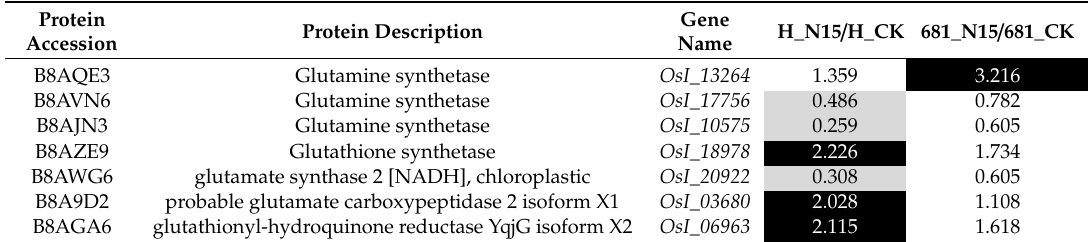
Table 2. The di ff erentially expressed proteins involved in ammonium assimilation in the comparisons of H_N15 vs. H_CK, and 681_N15 vs. 681_CK.